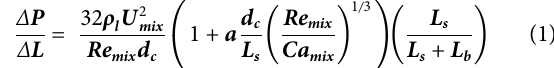
Frontiers in Chemical Engineering |